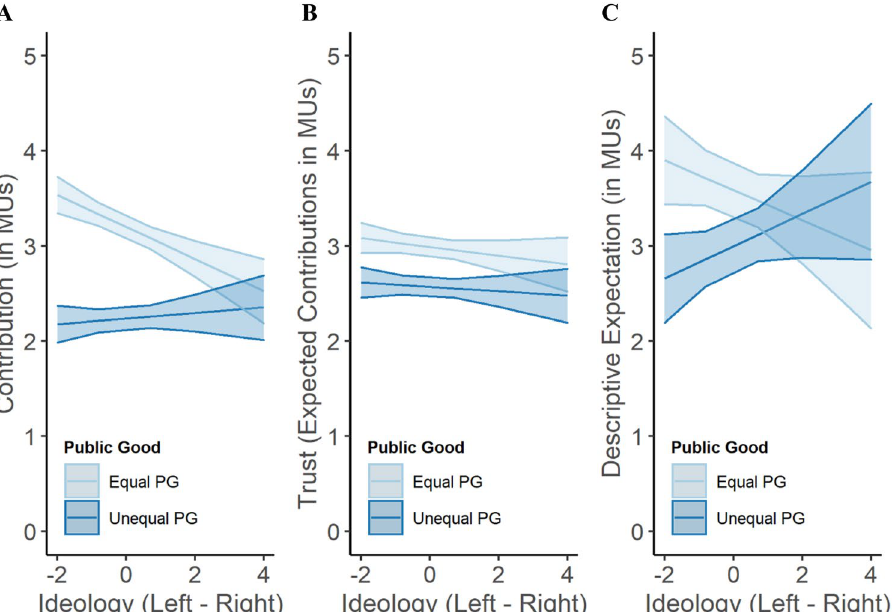
Figure 2. Ideology predicts cooperation, trust, and descriptive expectations. Cooperation on the equal and unequal public goods by leftists and rightists ( A ). Left- and right-leaning participants’ trust, measured as expectations of others’ contributions to the equal and unequal public good ( B ). Ideology predicts descriptive expectations about cooperation on the respective public goods ( C ). Specifically, left-leaning individuals expect others to contribute more to the equal than to the unequal public good, while right-leaning ones expect others not to differentiate between the two public